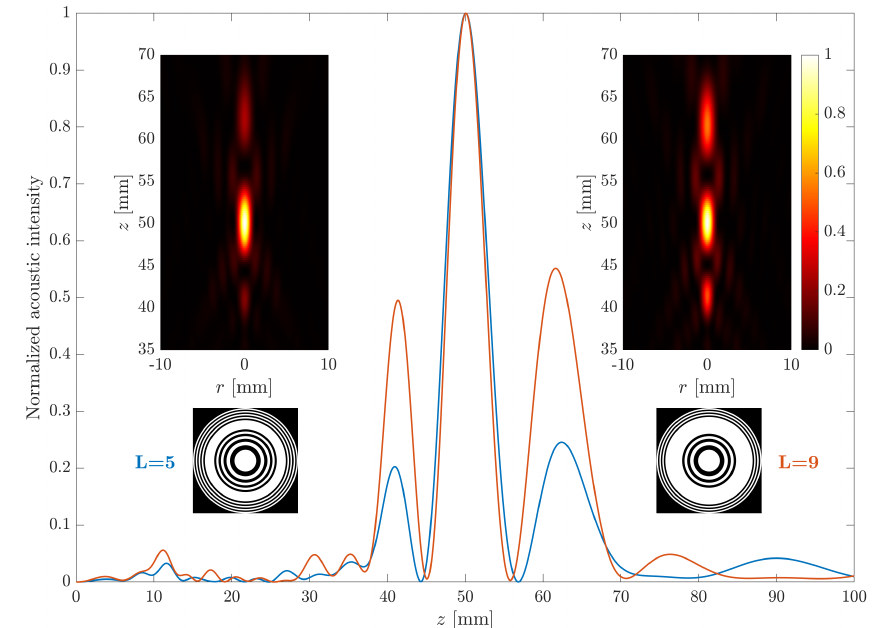
Figure 6. Normalized focusing profiles for L = 5 (blue) and L = 9 (red). The insets represent the corresponding intensity maps ( top ) and the layouts ( bottom ) of both